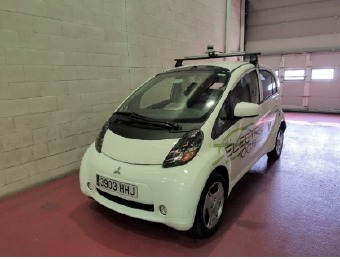
Figure 8. Autonomous vehicle used in tests.